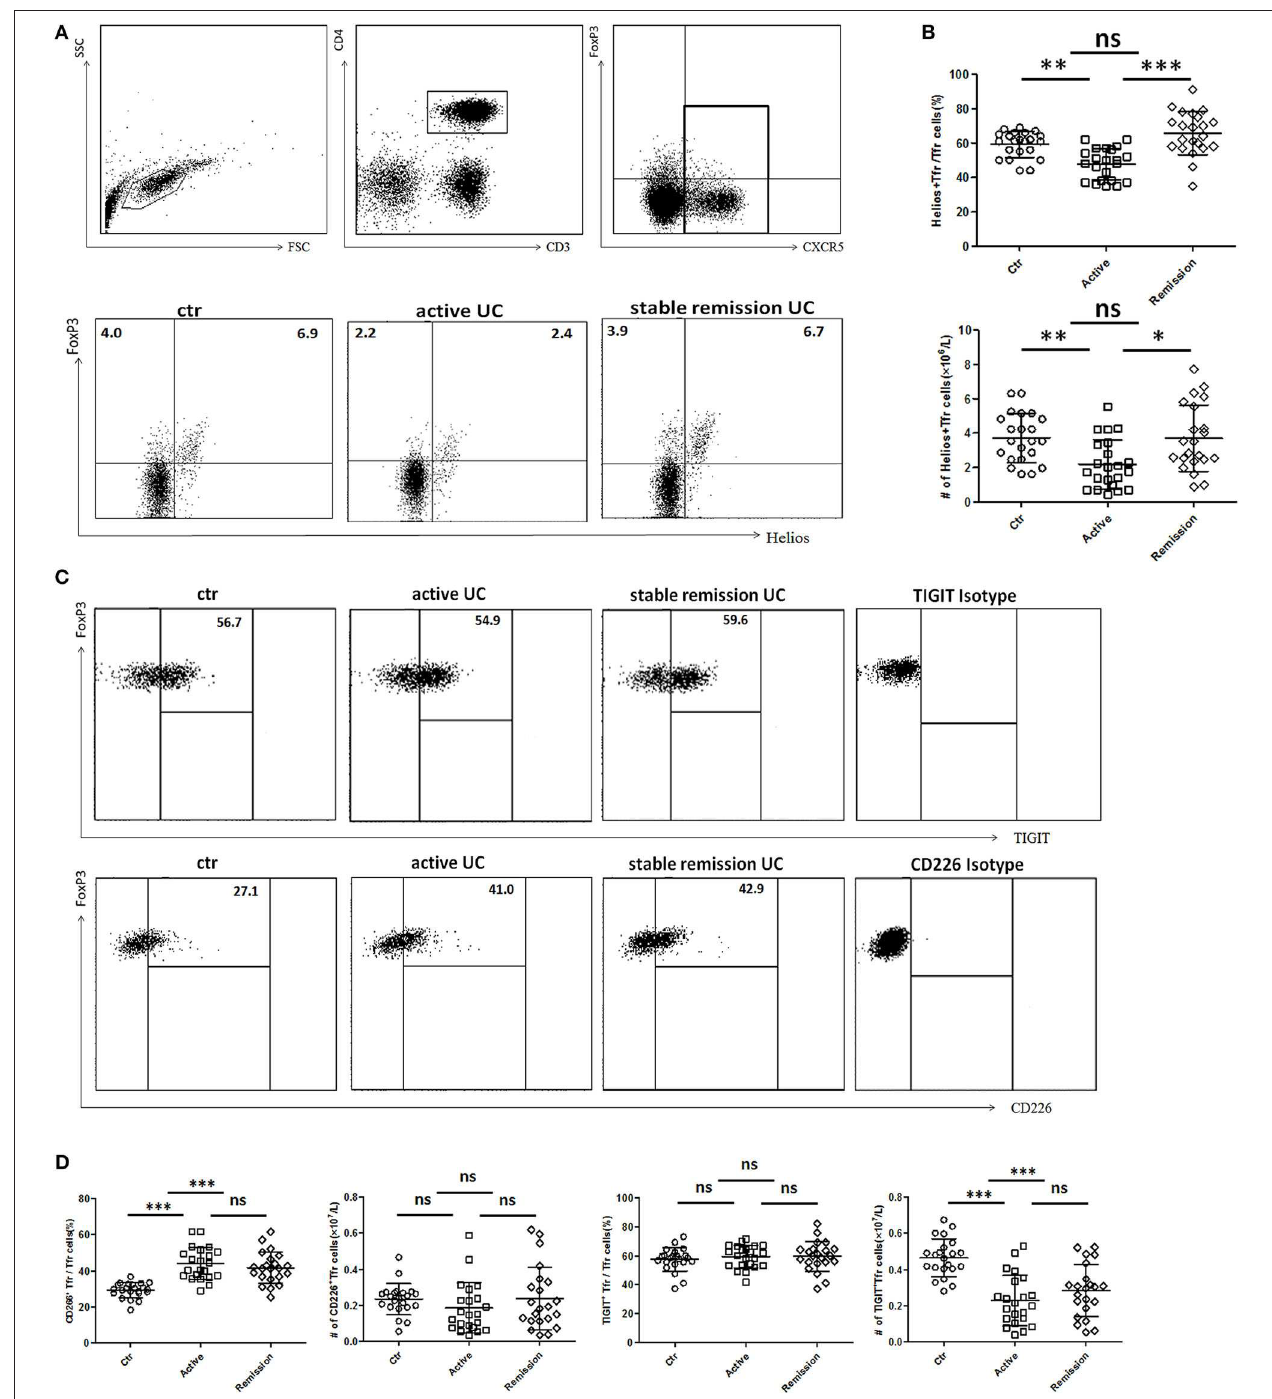
FIGURE 3 | Comparison of functional subsets of TFR from UC patients and healthy controls (HC) according to Helios, TIGIT, and CD226. Peripheral blood from UC patients subsequently enrolled in this research, including active UC patients ( n = 22) and stable remission UC patients ( n = 22) and HC ( n = 22) were collected and functional subsets of TFR cells were analyzed through staining for CD3, CD4, CXCR5, FoxP3, Helios, TIGIT, and CD226. (A) Representative dot plots for Helios and FoxP3 analysis. Numbers represent the percentages among CD3 + CD4 + CXCR5 + subsets. (B) Percentage of Helios + TFR cells among CD3 + CD4 + CXCR5 + FoxP3 + TFR cells (up) and absolute number of Helios + TFR cells per liter in active or stable remission UC and HC (bottom). (C) Representative dot plots for analyzing expression of TIGIT (up) or CD226 (bottom) among TFR. Numbers represent percentages of TIGIT or CD226 positive cells in CD3 + CD4 + CXCR5 + FoxP3 + TFR cells. (D) Percentages and absolute numbers of CD226 + TFR or TIGIT + TFR subsets among TFR cells were compared among active UC patients, stable remission UC patients and HC. All symbols represent individual subjects and bars show the mean ± SD. * p < 0.05; ** p < 0.01; *** p < 0.001; ns, not significant.